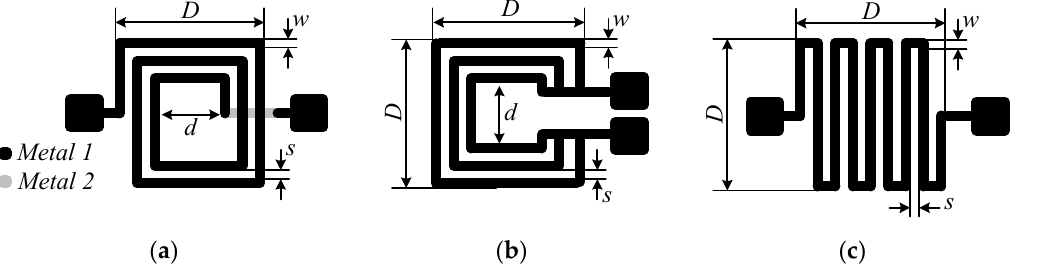
Figure 1. Investigated planar inductive sensor topologies: ( a ) spiral, ( b ) non-spiral, and ( c ) mean- der. Table 1. Geometrical dimensions of the PCB-based manufactured